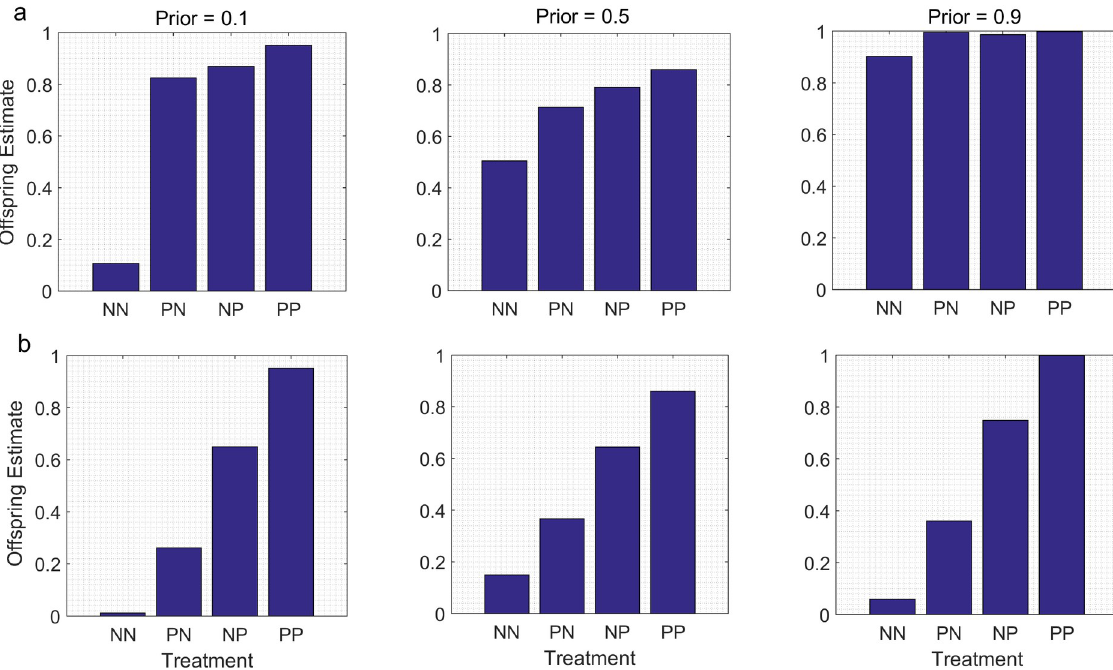
Fig 4. Information from parents is devalued or degraded before being passed to the offspring. We assume that parents and offspring in the P groups are exposed to the same cue for the same period of time, with a likelihood function indicated by α = 8, β = 1. However, the signal provided by the parent to the offspring as a result of the parent’s exposure to the cue is less reliable; it is modelled by a likelihood indicated by α = 3.5, β = 0.44. a. N- model: information provided by conditions in the N treatment is much less reliable than the information provided by conditions in the P treatment (likelihood for conditions in the N treatment modelled by α = 1, β = 1). b. N � model: conditions in the N treatment provide information that is as reliable as conditions in the P treatment (likelihood for N modelled by α = 1, β = 8). However, the signal that parents provide to their offspring as a result of exposure to conditions in the N treatment is less reliable, with a likelihood modelled by α = 0.44, β =